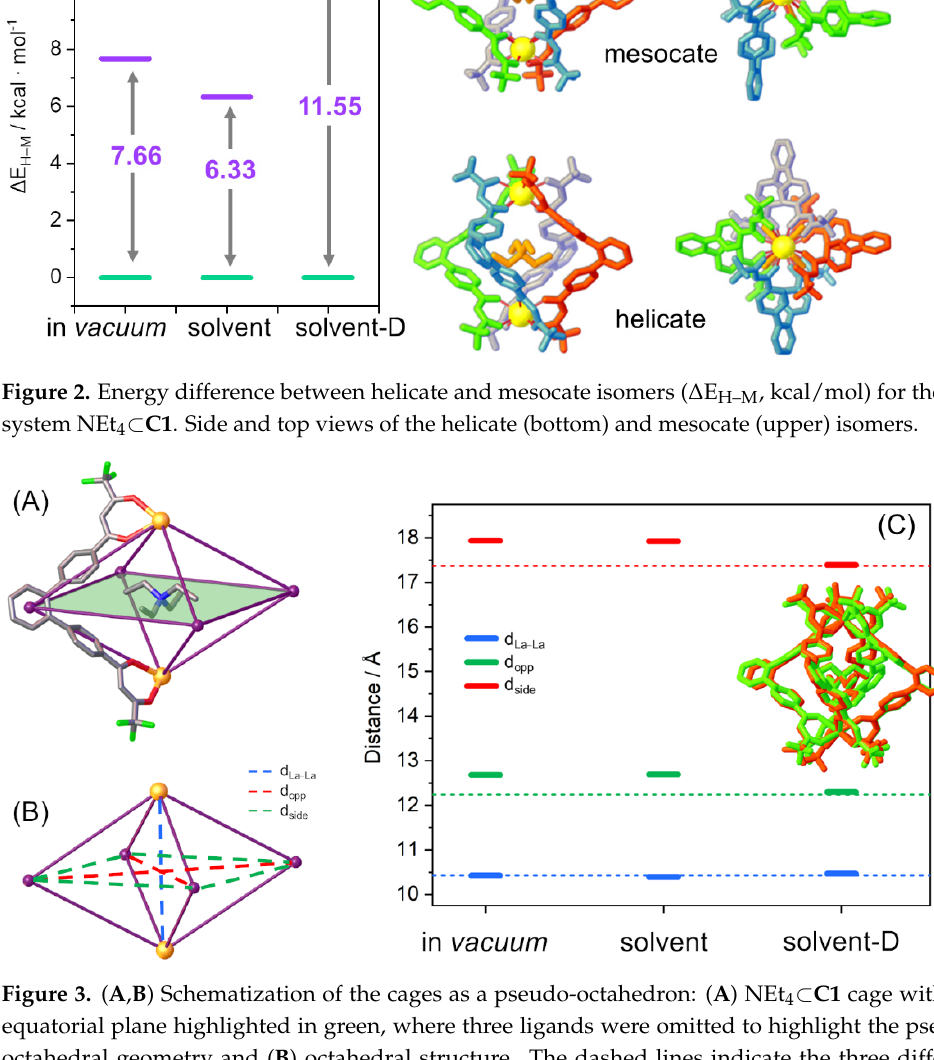
Figure 2. Energy difference between helicate and mesocate isomers ( Δ E H–M , kcal/mol) for the test system NEt 4 ⸦ C1 . Side and top views of the helicate (bottom) and mesocate (upper) isomers. However, even if all methods are almost equivalent to predicting the most stable iso-